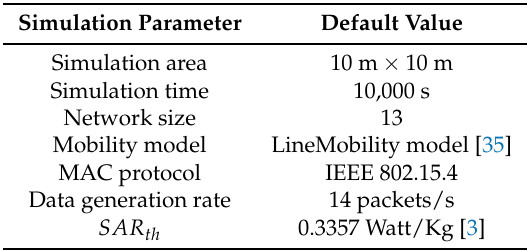
Table 3. Simulation parameters and their default